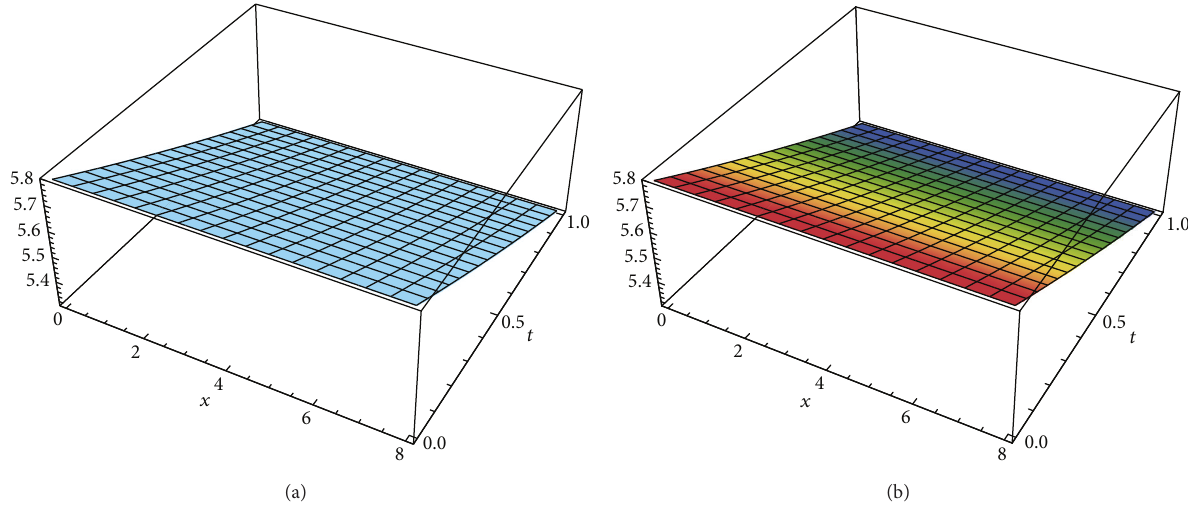
V V V V V V V V 0 + 1 + 2 + 3 + 4 + 5 + 6 + 7 + 8 .